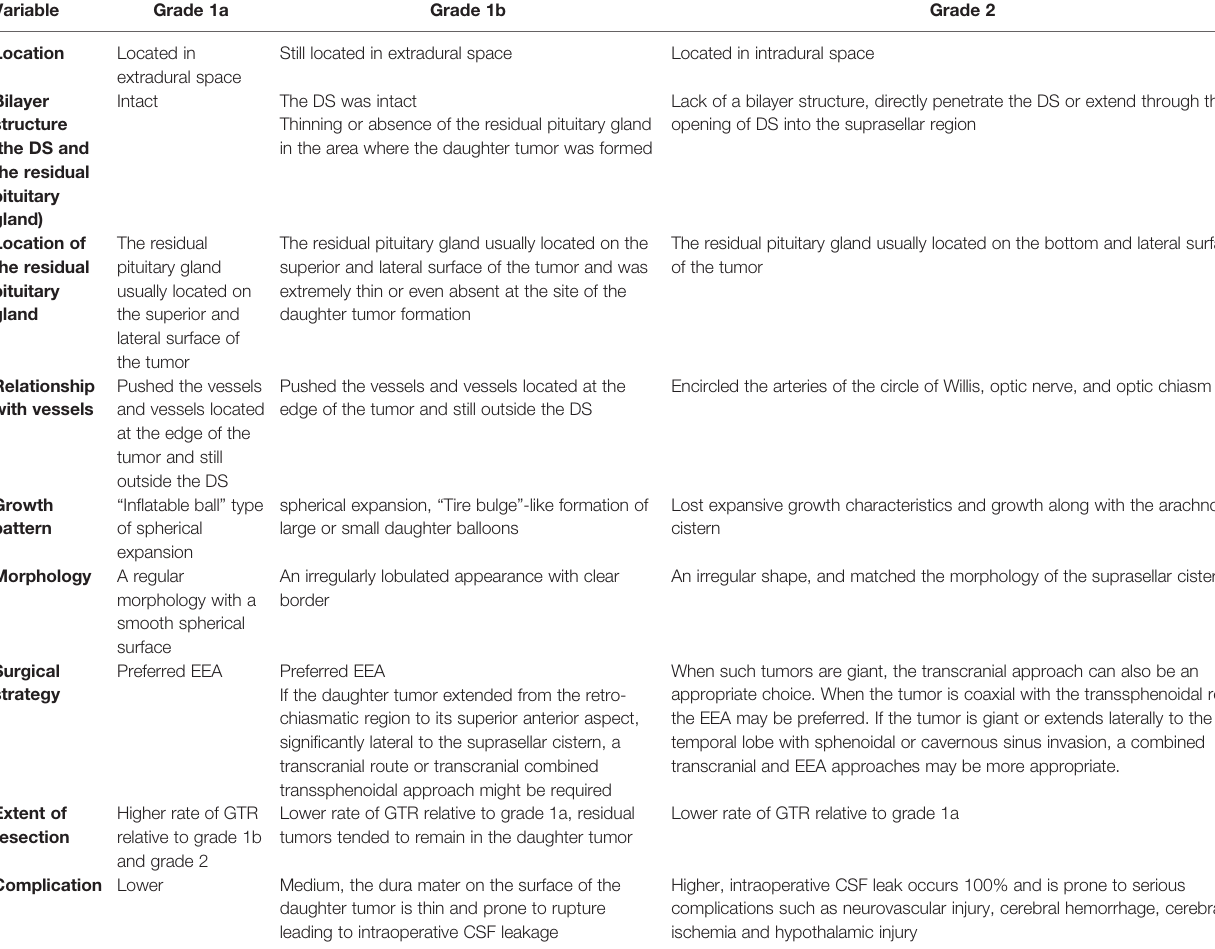
TABLE 3 | Characteristics and surgical strategies and outcomes of each